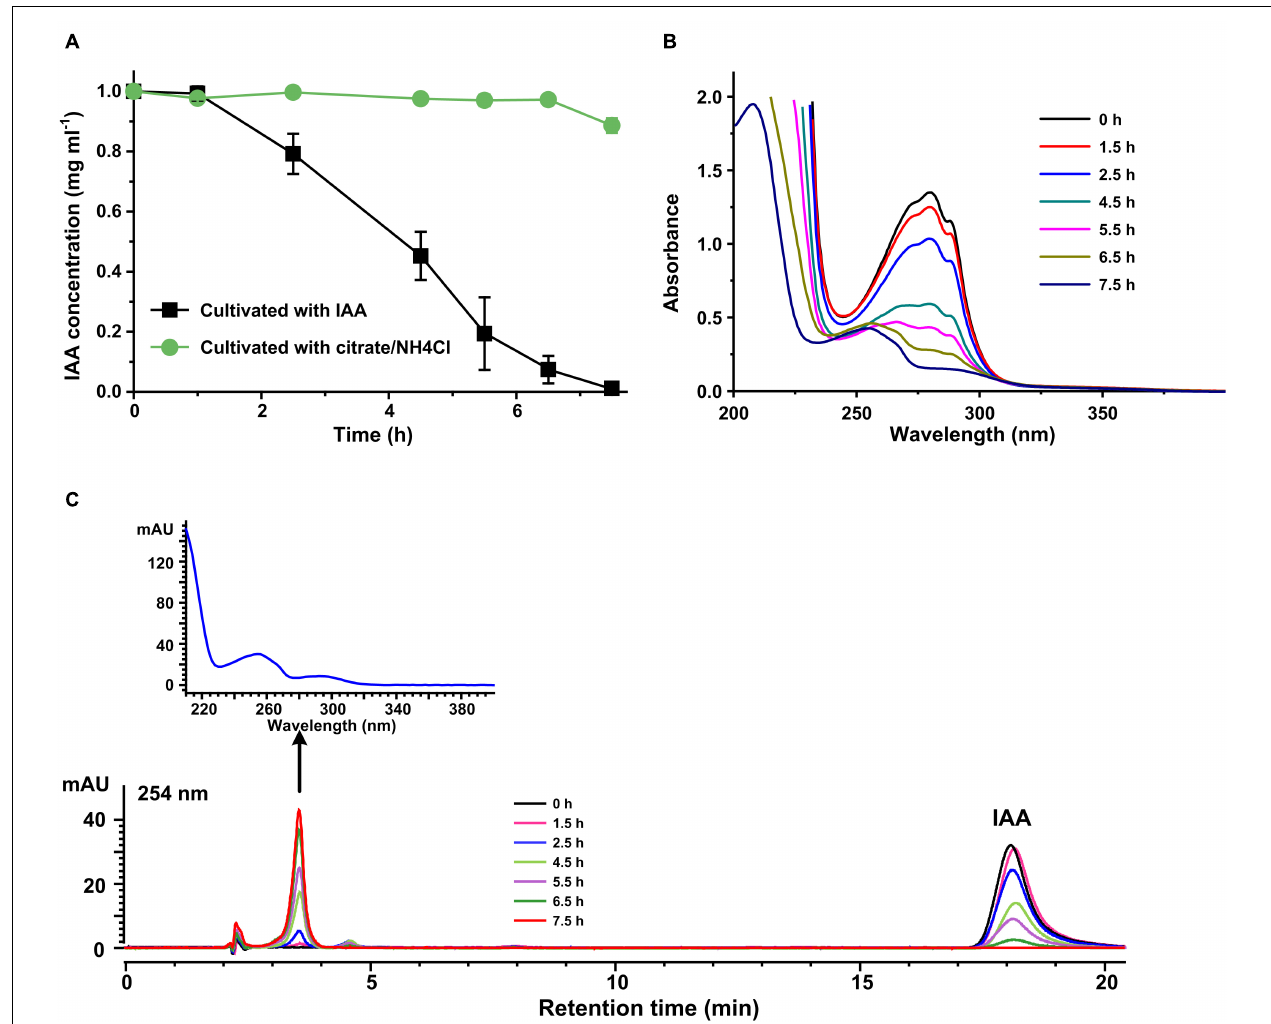
FIGURE 1 | Indole-3-acetic acid (IAA) transformation by resting cells of strain LY1. (A) IAA (2,000 mg/L) degradation by resting cells of strain LY1 cultivated with IAA ( (cid:4) ) and citrate/NH 4 Cl ( ), respectively. The cell density of resting cells is OD600 = 6.0. The reaction was performed at 30 ◦ C 120 rpm. (B) UV scanning of the samples at interval times from IAA transformation reactions. The reactions were performed with resting cells of strain LY1 cultivated with IAA. (C) HPLC analysis of (cid:32) the samples at interval times from IAA transformation reactions. The reactions were performed with resting cells of strain LY1 cultivated with IAA. The signal at 254 nm was recorded. The arrow indicated the UV spectrum of the compound with a retention time of 3.60 min. The mobile phase was 35% (v/v) methanol and 65% (v/v) 0.05% formic acid. The HPLC column was Agilent XBD C18 (4.6 mm × 250 mm, 5 µ m). Each value is the mean from three parallel replicates ±